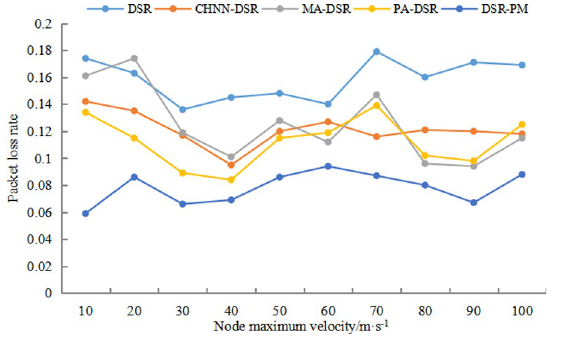
Fig 4. Packet loss rate comparison diagram.